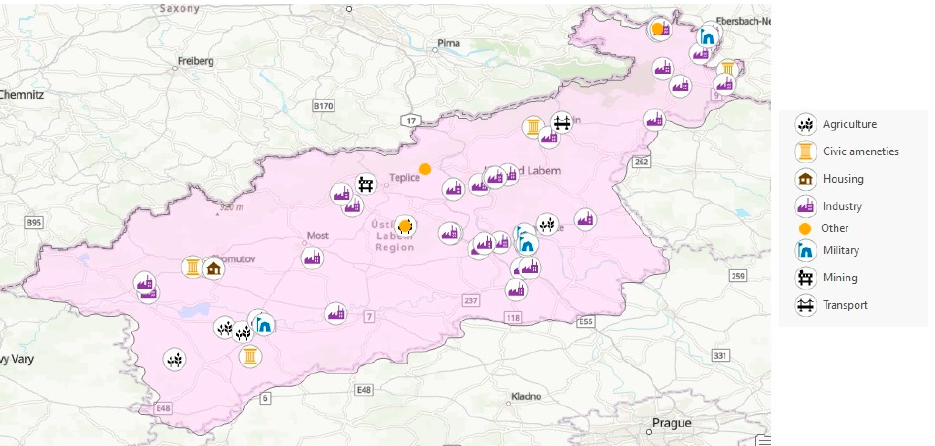
Figure 2. Map of brownfields in the Ústí Region; own creation based on mapping with geographic information tools (ArcGIS) using data from [41].